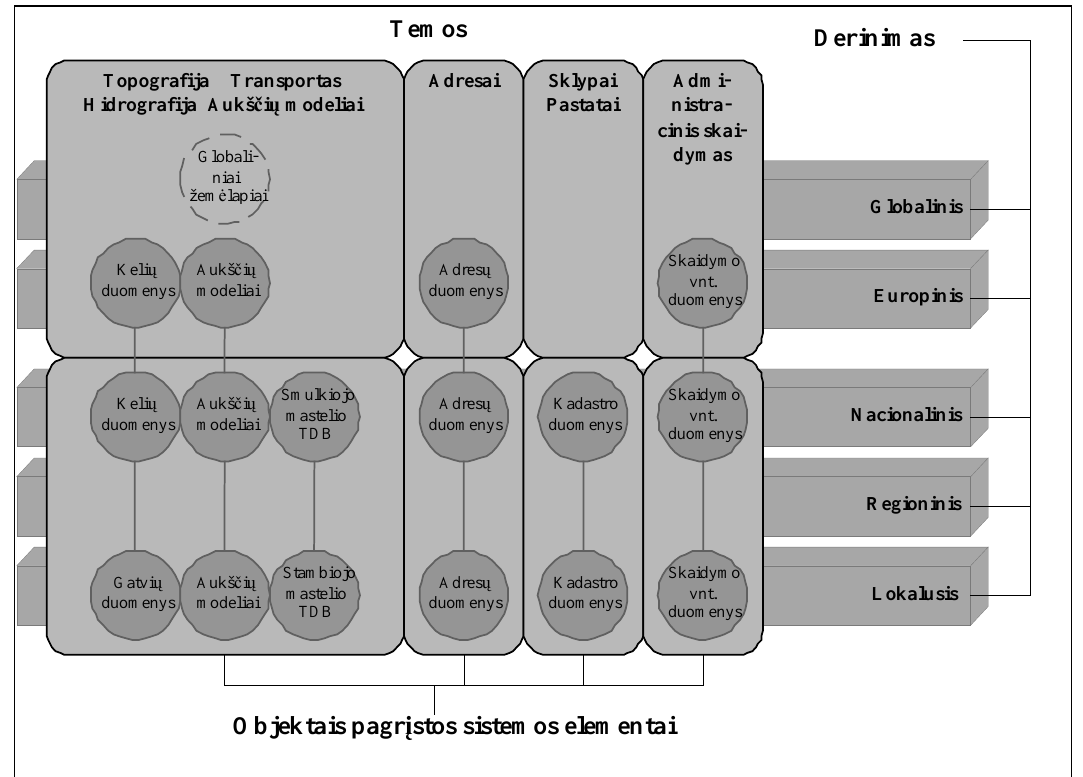
Fig 1 . Multilevel adjustment of themes and levels, and object-based